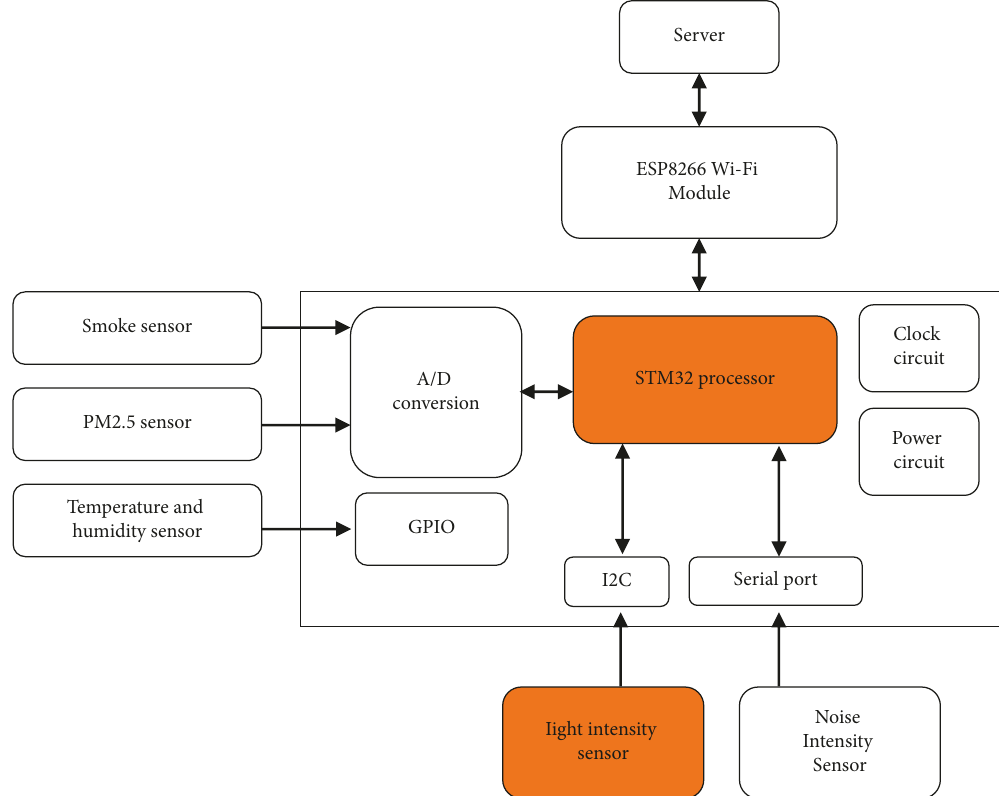
Figure 2: Hardware structure of environment parameter collection and transmission